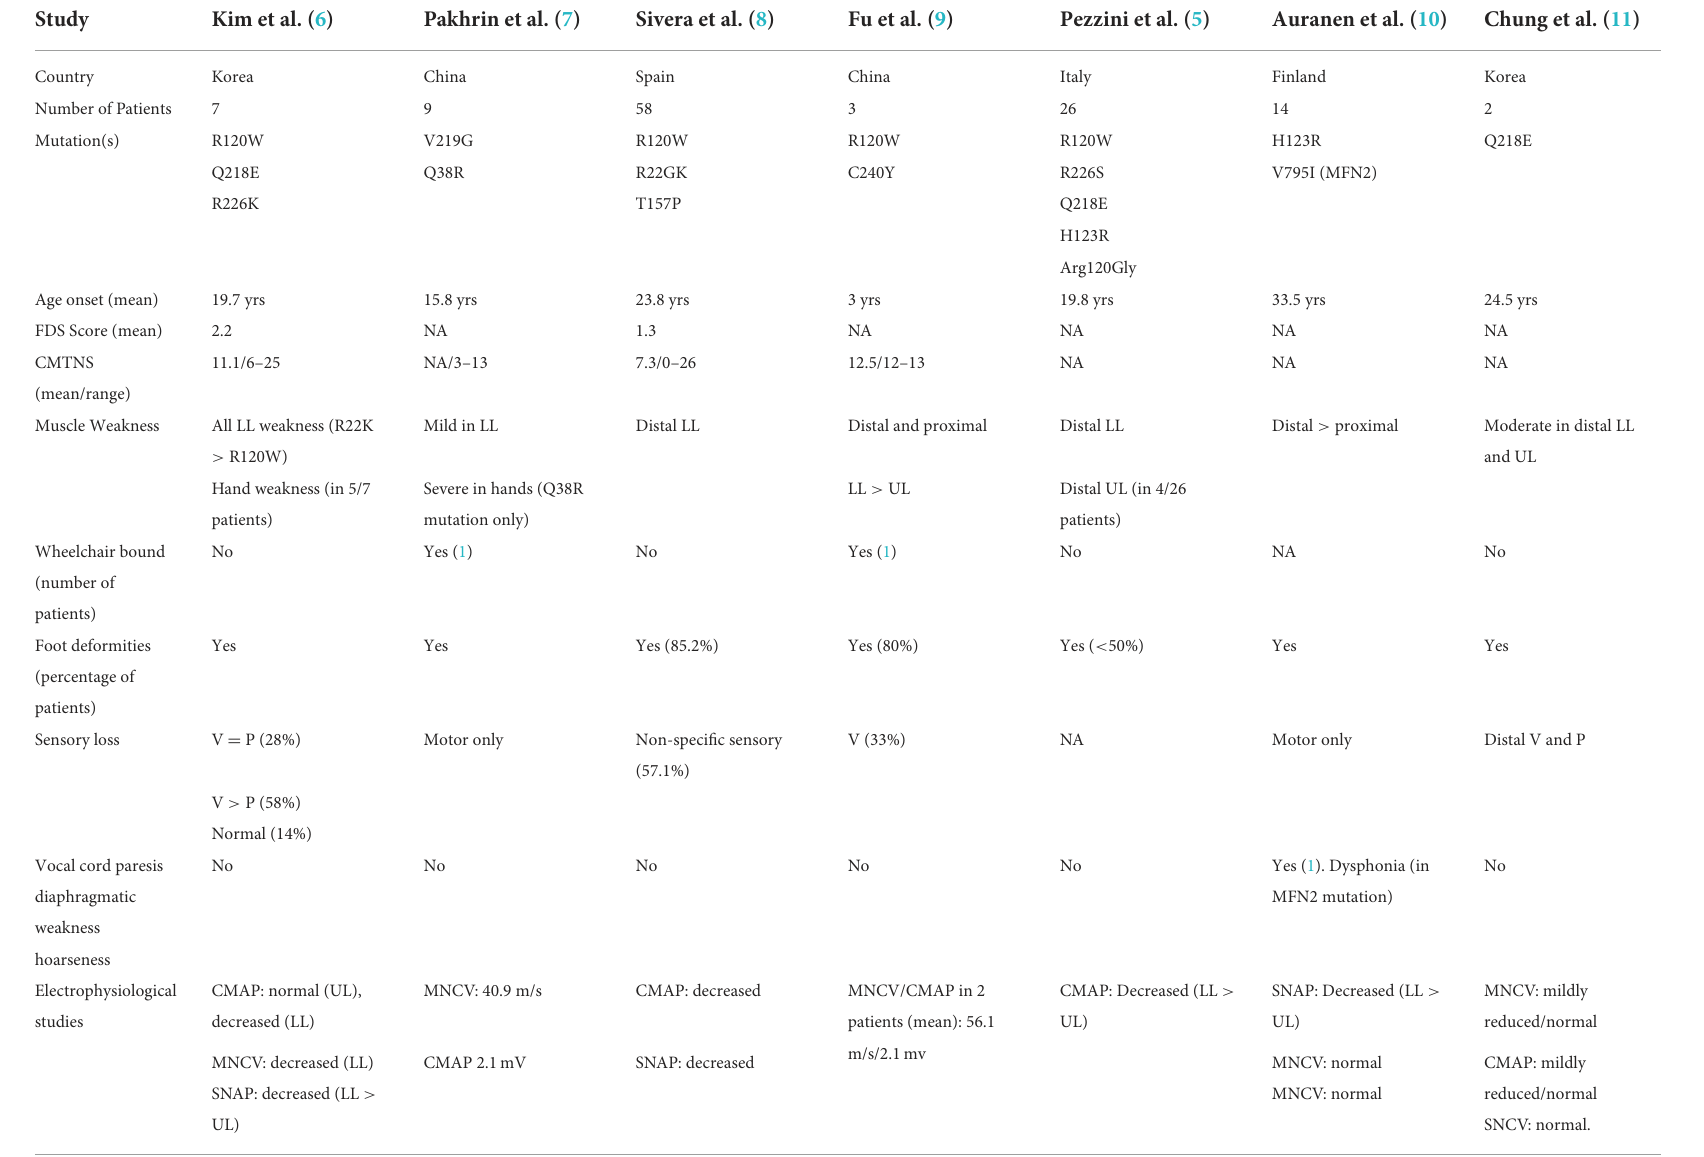
TABLE 3 Clinical characteristics of patients with various autosomal dominant mutations in the ganglioside induced differentiation associated protein 1 (GDAP1) gene.